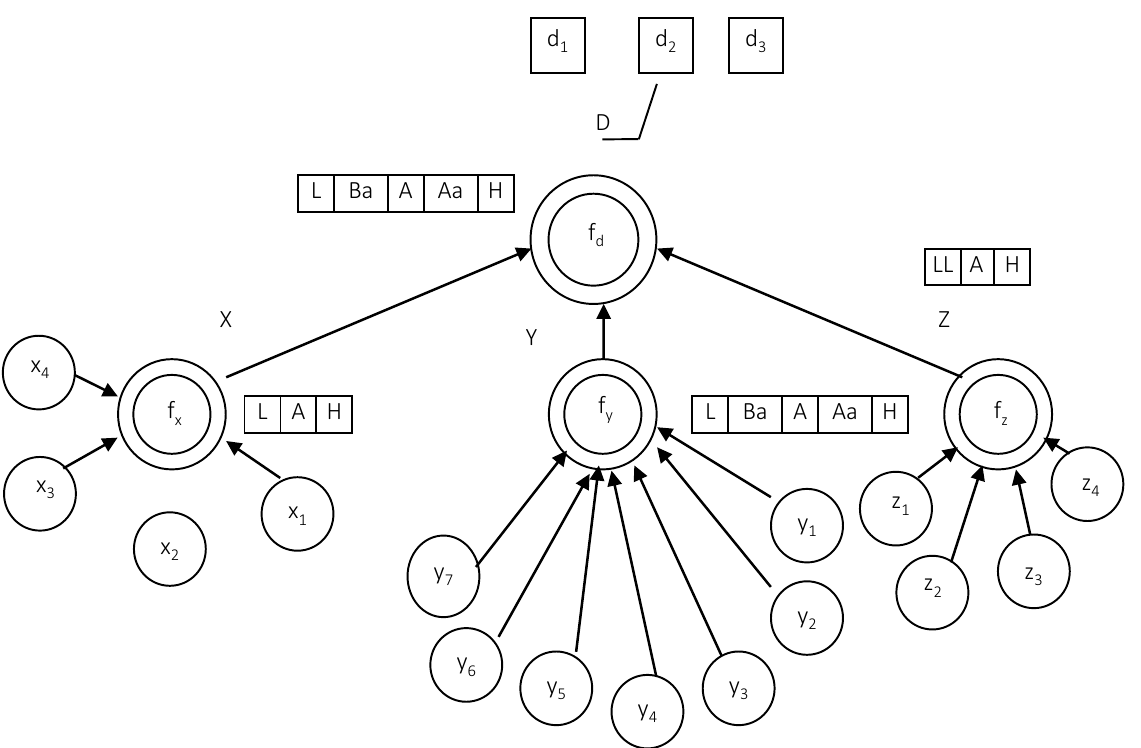
Figure 4. The tree of logical conclusion for hierarchical relationships of